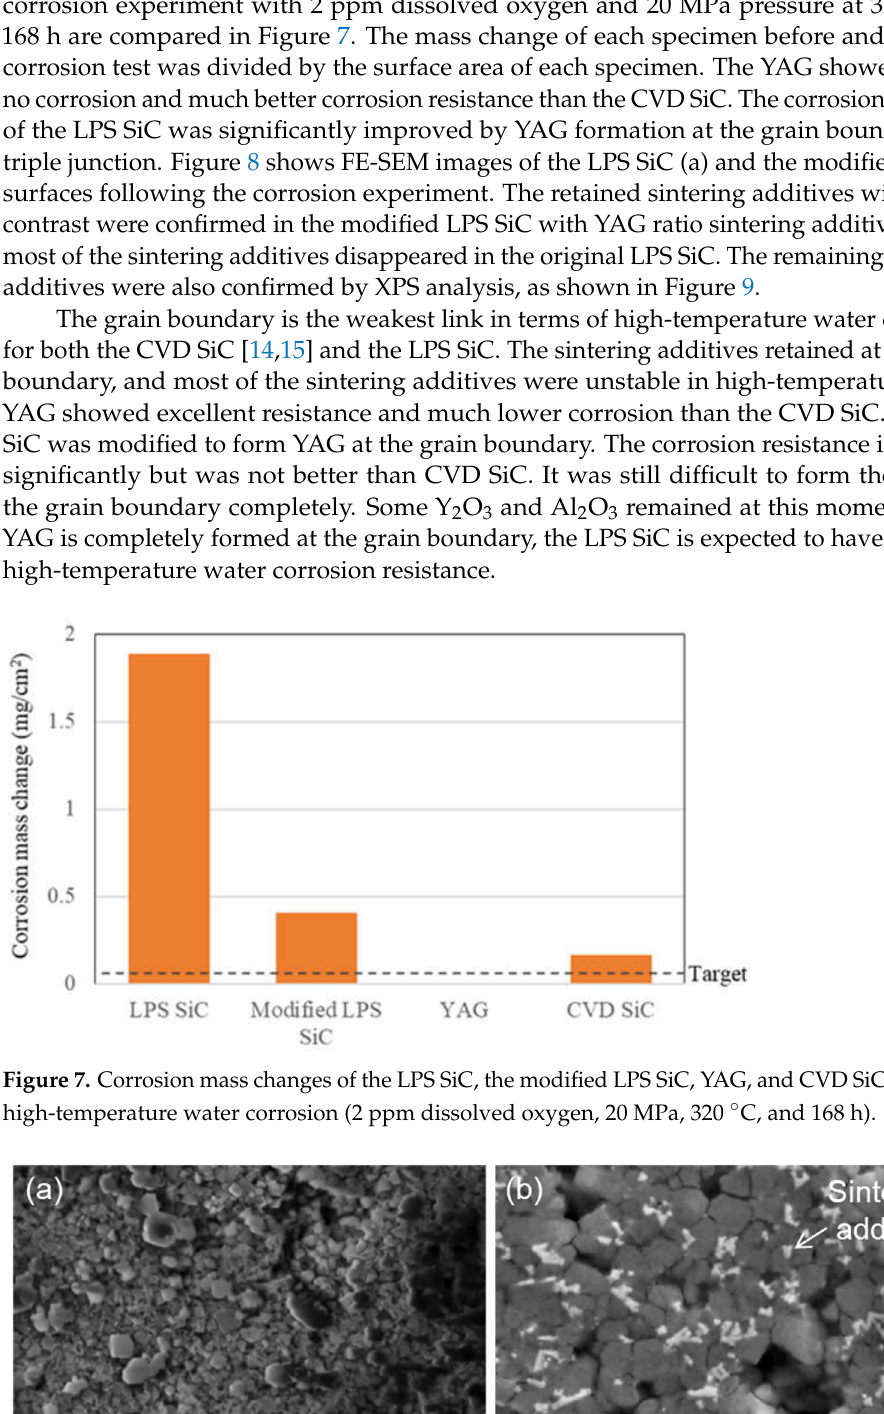
Figure 6. A SEM image of the LPS SiC following high-temperature water corrosion (8 ppm dissolved oxygen, 20 MPa, 360 °C, and 168 h).